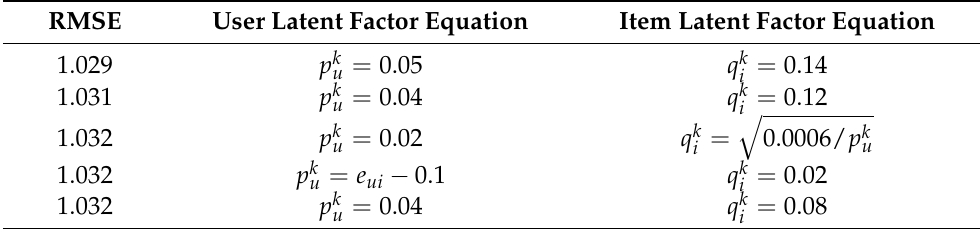
Table 9. MovieLens optimization results.